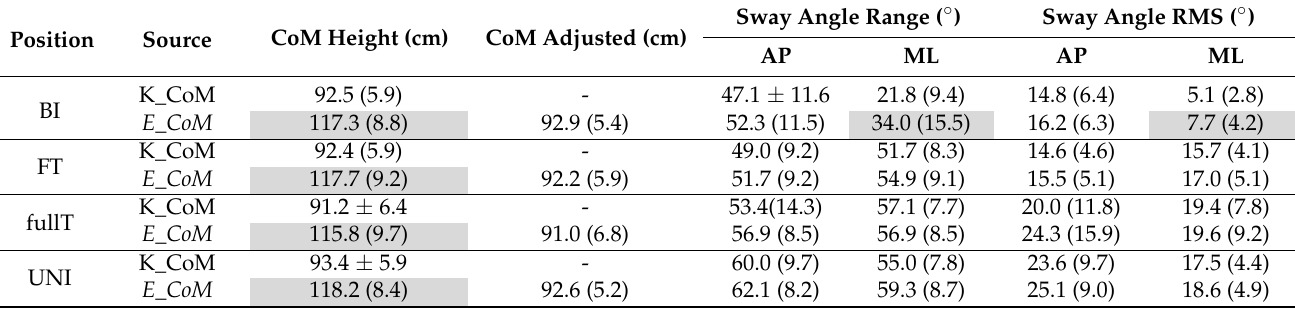
Shaded values represent significant differences with E _ CoM for parametric ( p < 0.05) or non-parametric data ( p < 0.017). BI: bipodal; FT: feet together; fullT: full tandem; UNI: